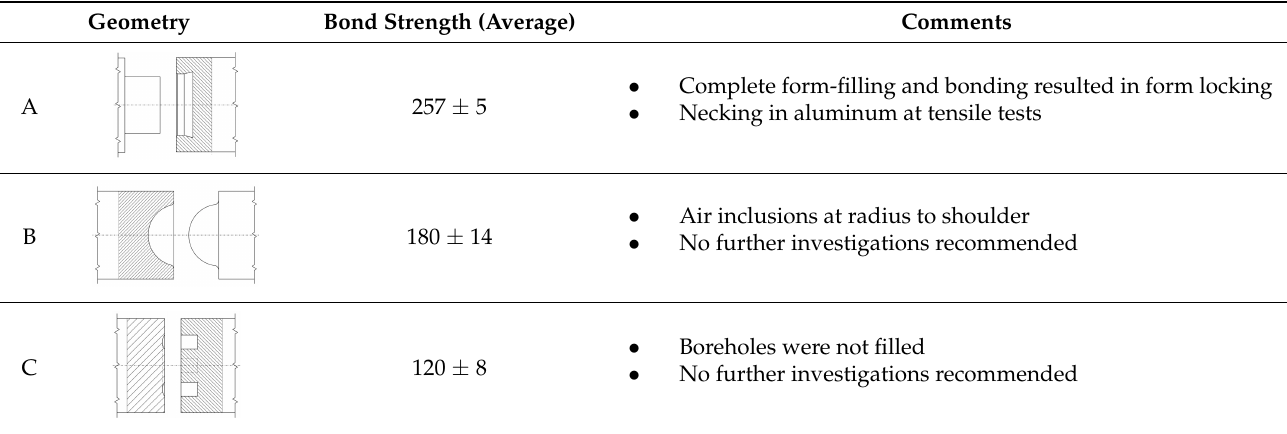
Table 4. Results of the different geometries with regard to the further process.